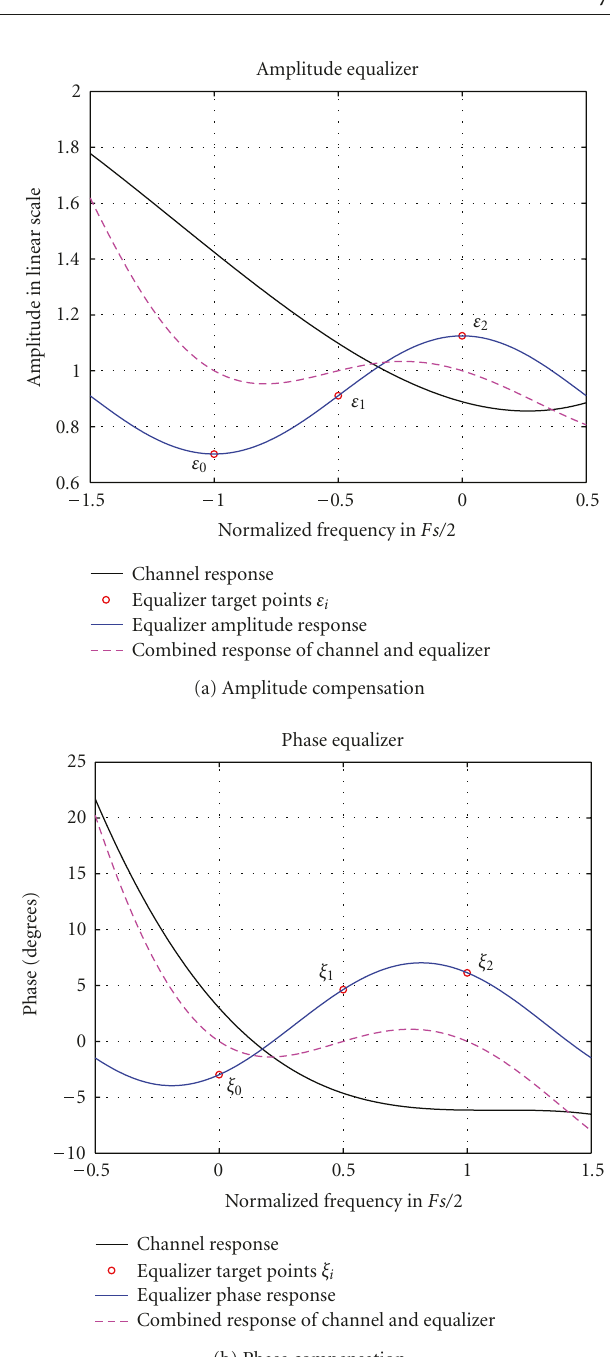
Figure 5: An example of AP-FBEQ subband equalizer